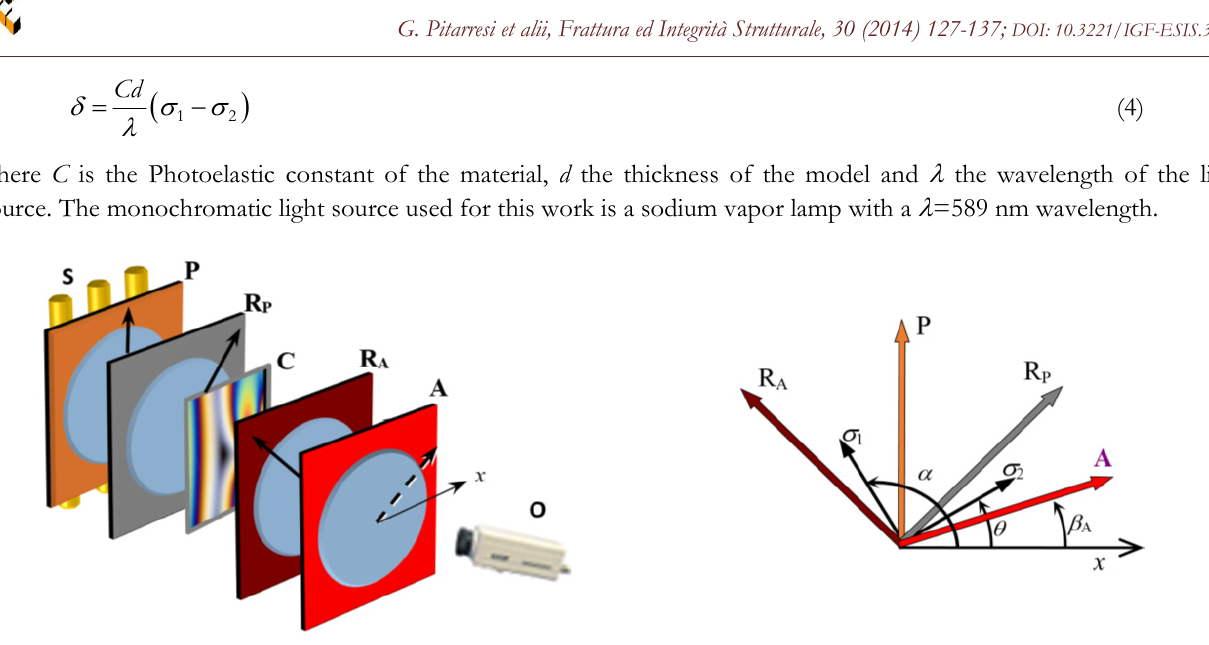
Figure 1: Tardy Phase-Shifting Method: polariscope